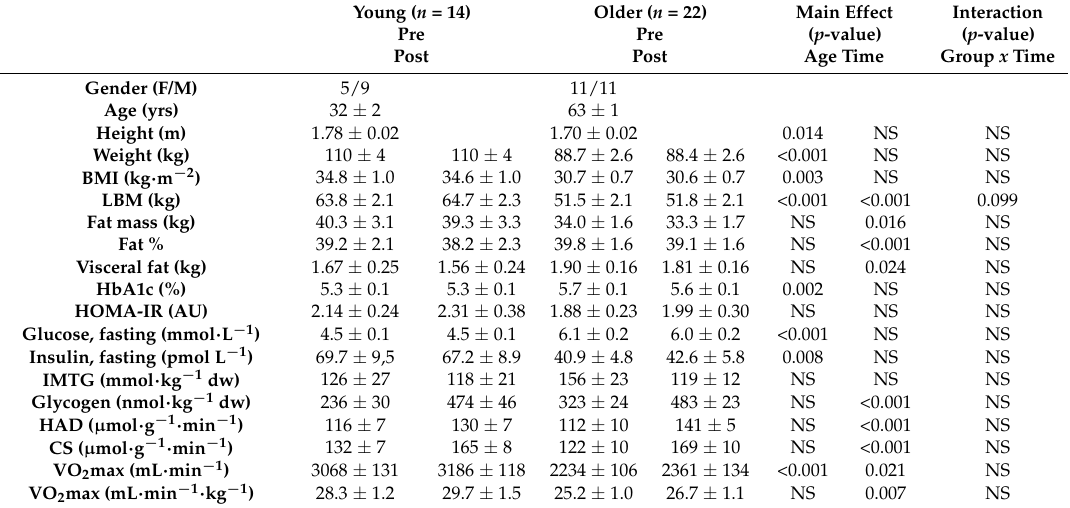
Table 1. Subject